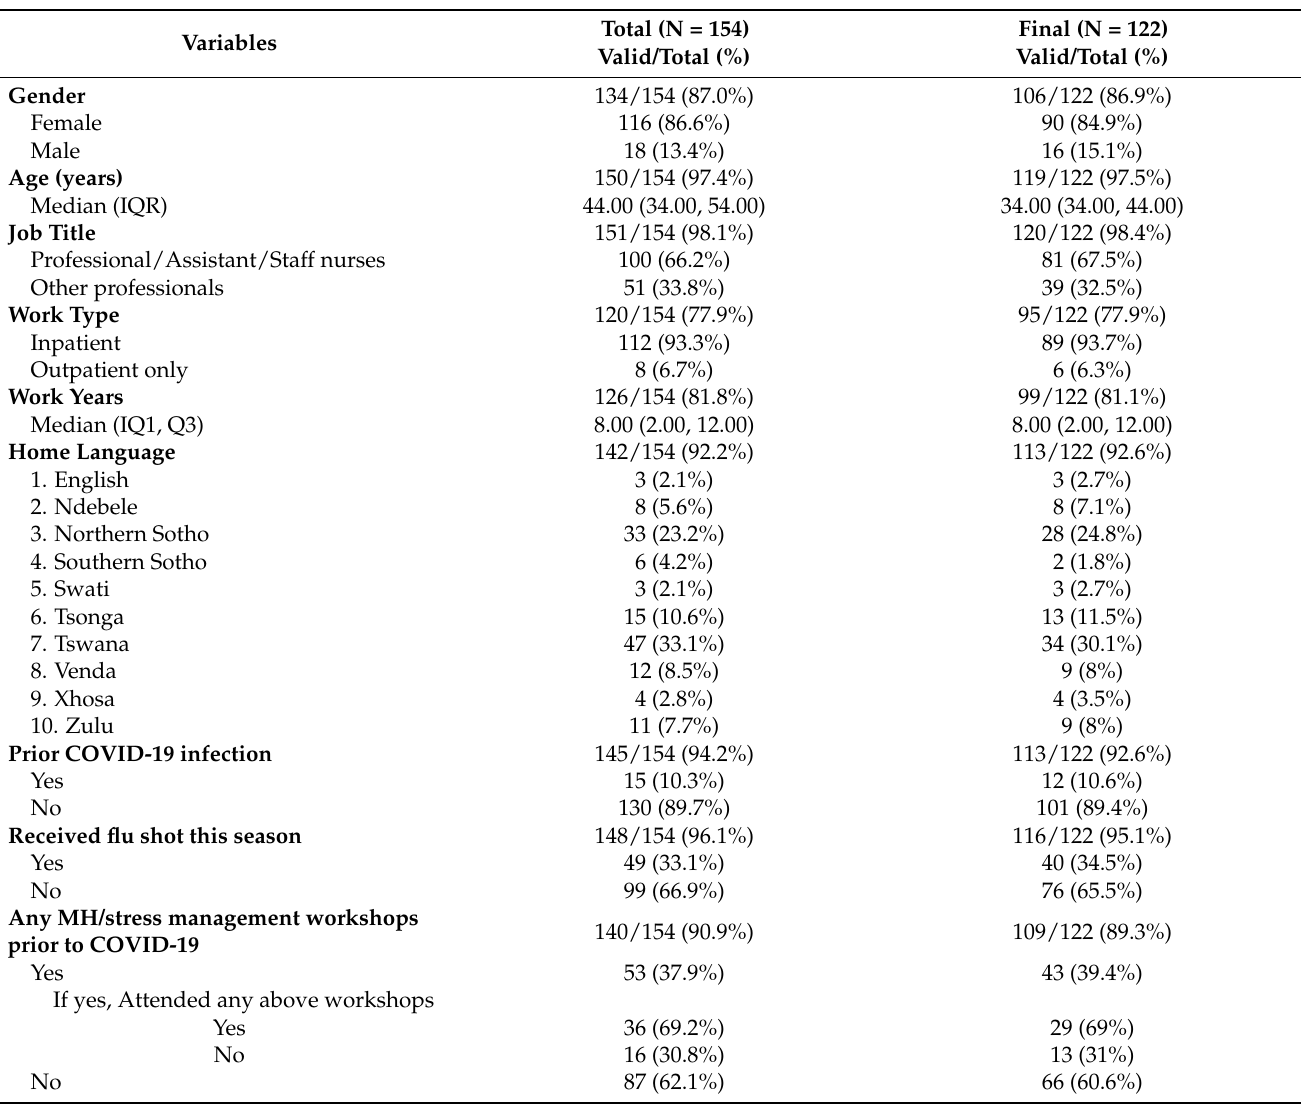
Table 1. Demographic characteristics of 122 participants for final analysis and comparison between the final (N = 122) and the original (N = 154)